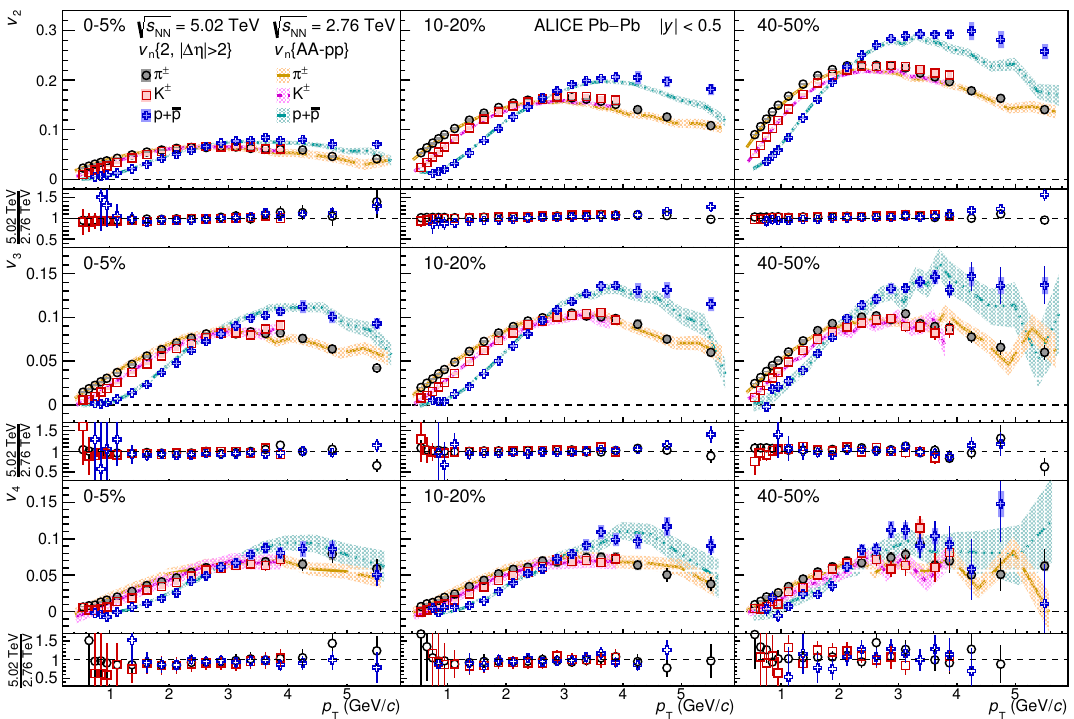
Figure 23 . (Colour online) The p T -di(cid:11)erential v 2 (top), v 3 (middle), and v 4 (bottom) of (cid:25) (cid:6) , K (cid:6) , p and p+p compared to ALICE measurements performed in Pb-Pb collisions at s NN = 2.76 TeV (coloured bands) [28] for the 0{5%, 10{20%, and 40{50% centrality classes. For the measurements at p s NN = 5.02 TeV, statistical and systematic uncertainties are shown as bars and boxes, respectively. p For the measurements at s NN = 2.76 TeV, the thickness of the bands corresponds to the quadratic p sum of statistical and systematic uncertainties. The ratios of measurements at s NN = 5.02 TeV p to a cubic spline (cid:12)t to the measurements at s NN = 2.76 TeV are also presented for